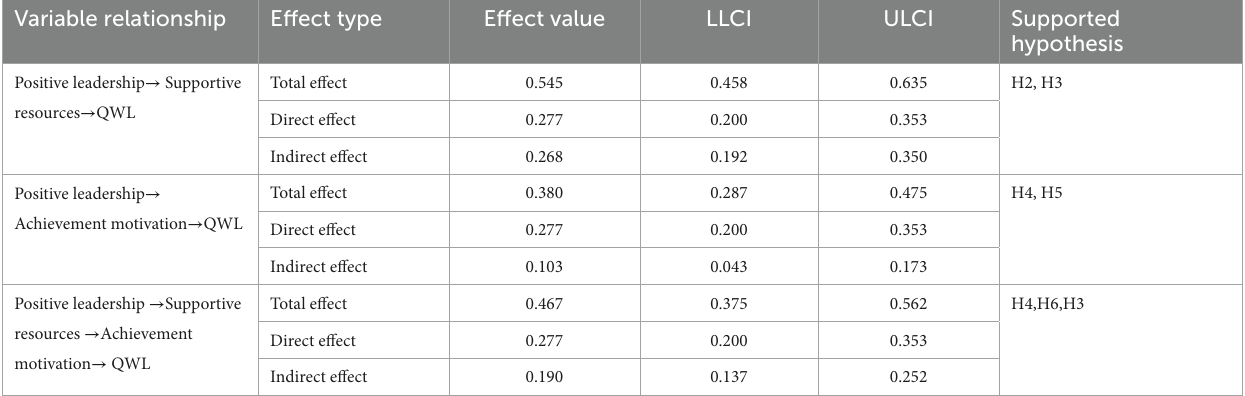
TABLE 6 Bootstrap confidence interval estimation results of the simple mediating effect. Variable